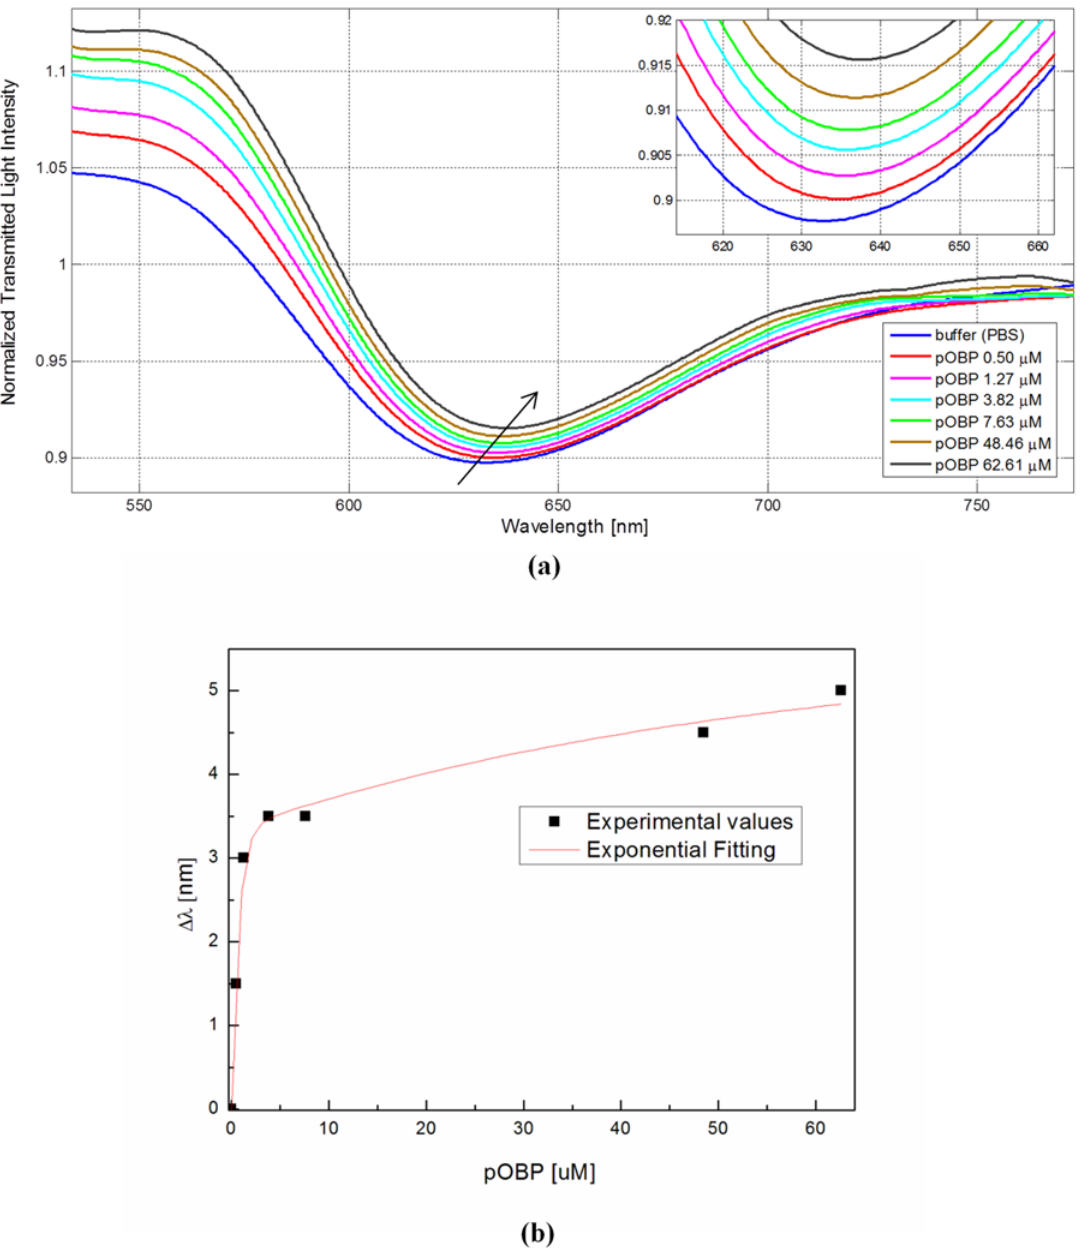
Fig 4. Binding experiment-SPR results. (a) SPR transmission spectra, normalized to the air spectrum, for different pOBP concentrations in the case of sensor with gold layer with bio-receptor. Inset: Zoom of the resonance wavelengths region. (b) Resonance wavelength variation as a function of pOBP concentrations [ μ